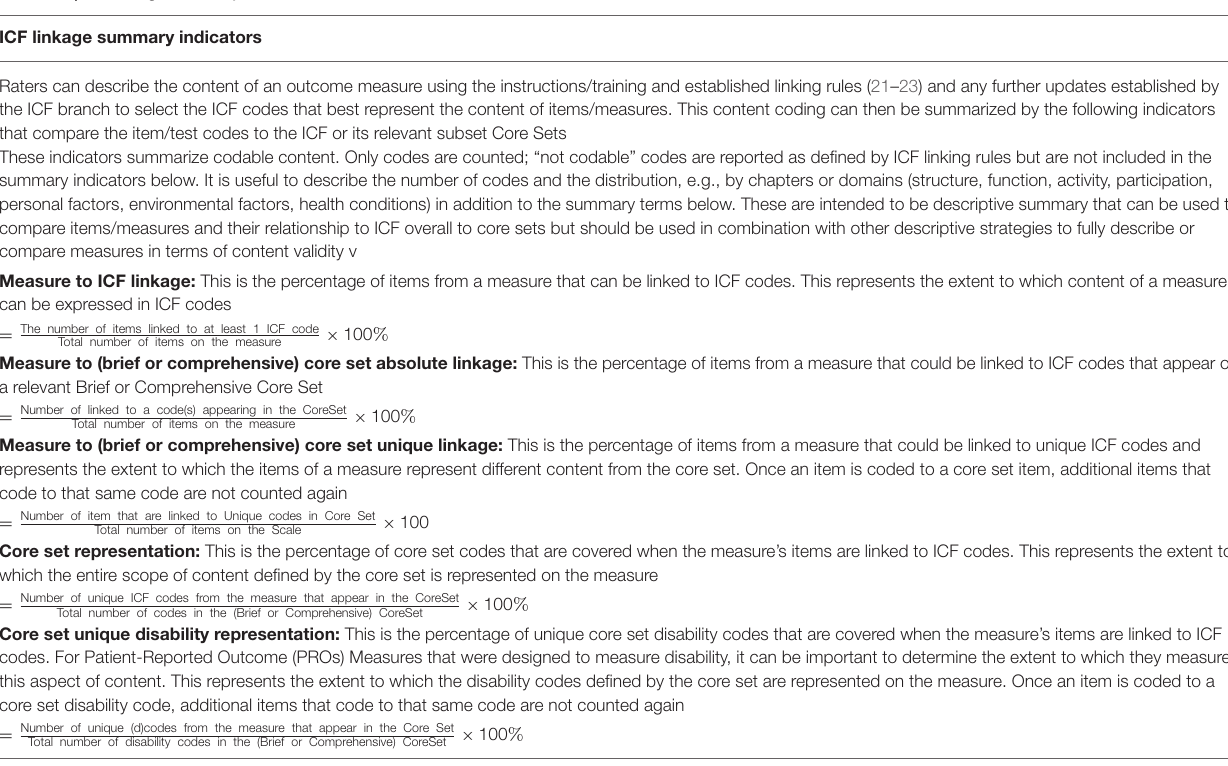
TABLE 3 | ICF linkage summary